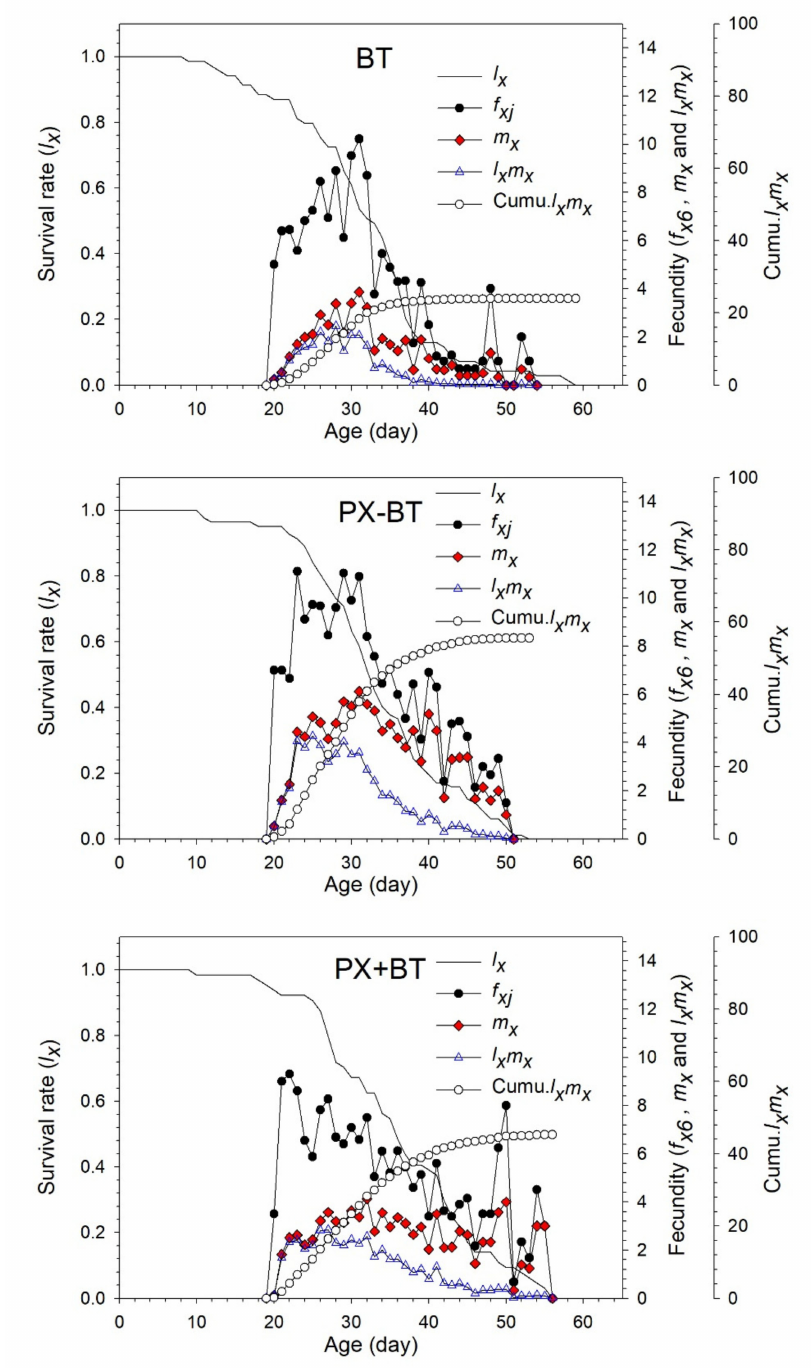
Figure 3. Age-specific survival rate ( l x ), female age-stage specific fecundities ( f x ), fecundity ( m x ) and net maternity ( l x m x ) of Bemisia tabaci when feeding on Chinese kale alone (BT), with prior Plutella xylostella damage (PX − BT) or with simultaneous P. xylostella damage (PX + BT). The age-stage specific reproductive values ( v xj ) of B. tabaci represented the contribution of an individual at age x and stage j to the future population (Figure 4). The reproductive peaks of 43.5 and 43.7 occurred at 20 and 24 days of age, respectively, in the BT treatment. In contrast, the peaks of v xj that occurred at 23 and 21 days were as high as 56.5 and 53.9 eggs in the PX − BT and PX + BT treatments, respectively, which were significantly higher than the peaks in the BT